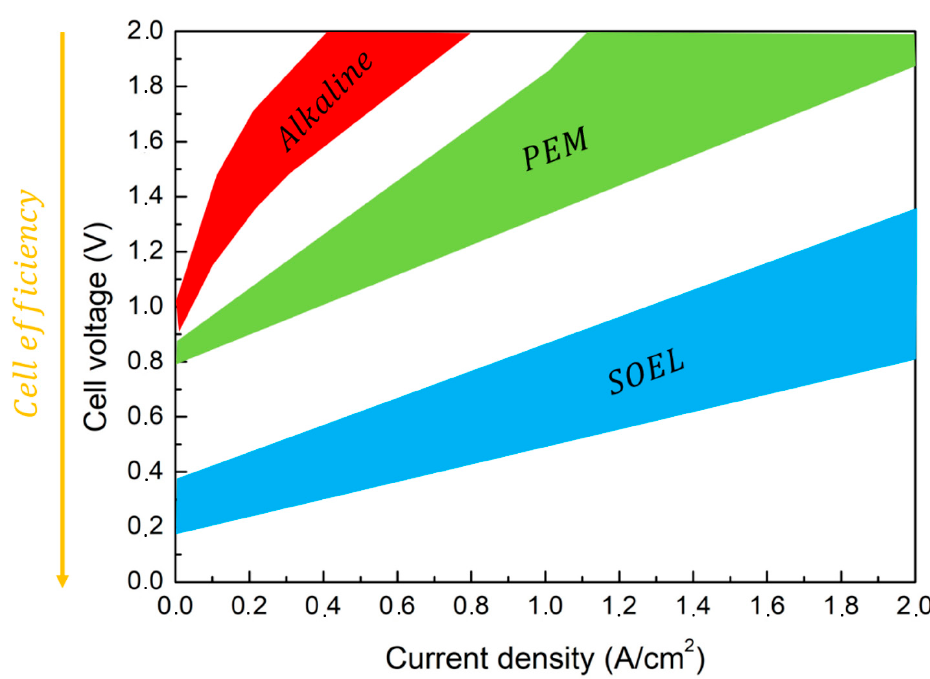
Figure 3. Electrolyzers comparison.